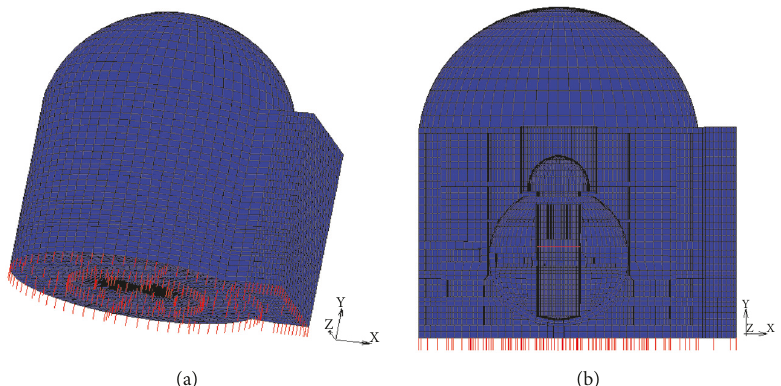
Figure 4: Isolated CB model: view (a) and section (b). In this latter RPV (-9 m below the ground) is represented by the red ties inside containment